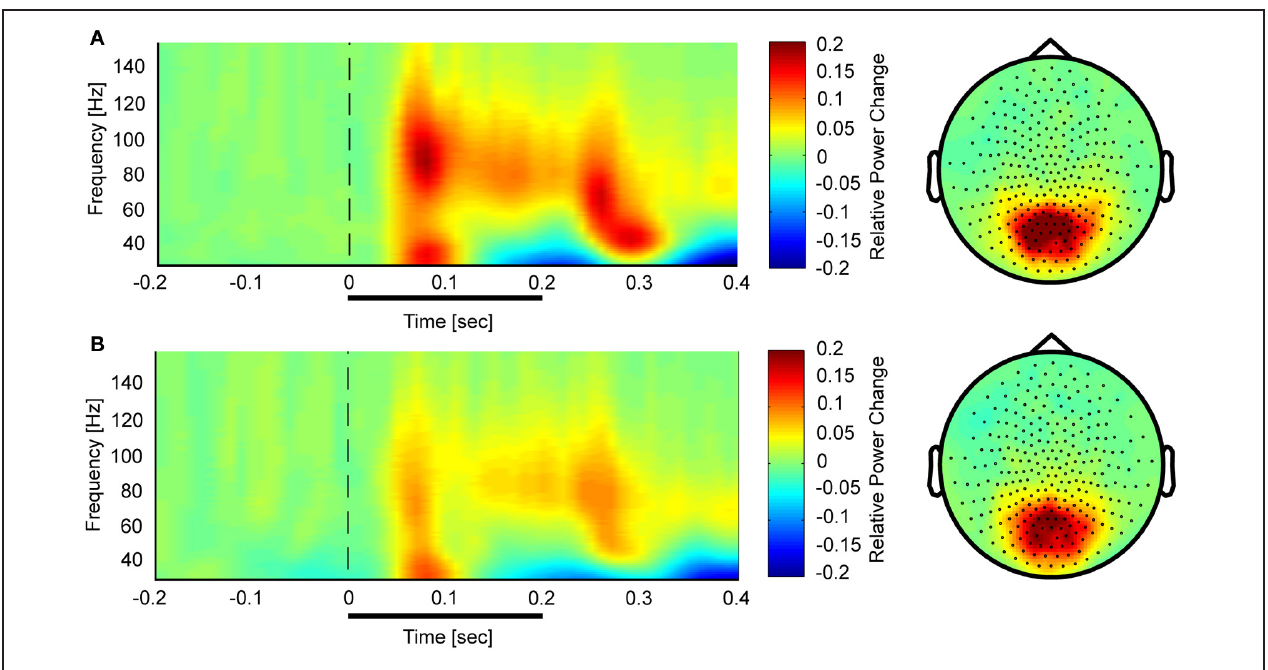
FIGURE 3 | Time-frequency representations and topographies of gamma-band spectral power in the face condition for controls (A) and schizophrenia patients (B). The gamma-band signal is expressed as relative